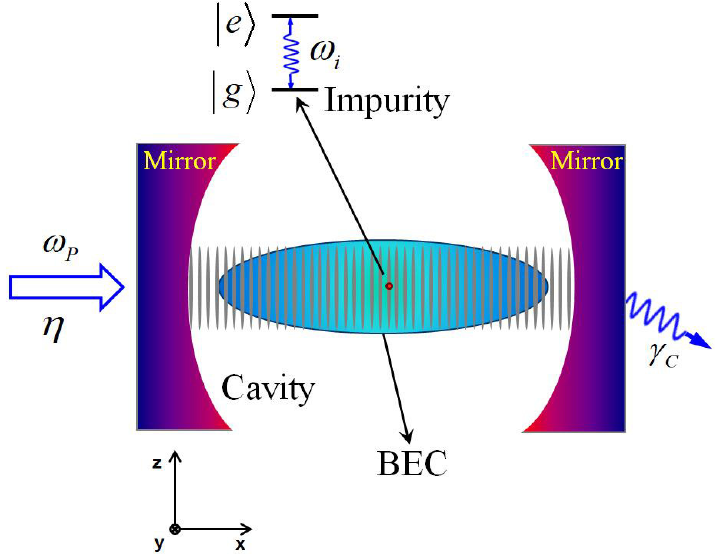
Figure 1. Schematic diagram of the cavity–BEC (cigar-shaped) system with a two-level impurity. The BEC is confined in a cylindrically symmetric trap with a transverse trapping